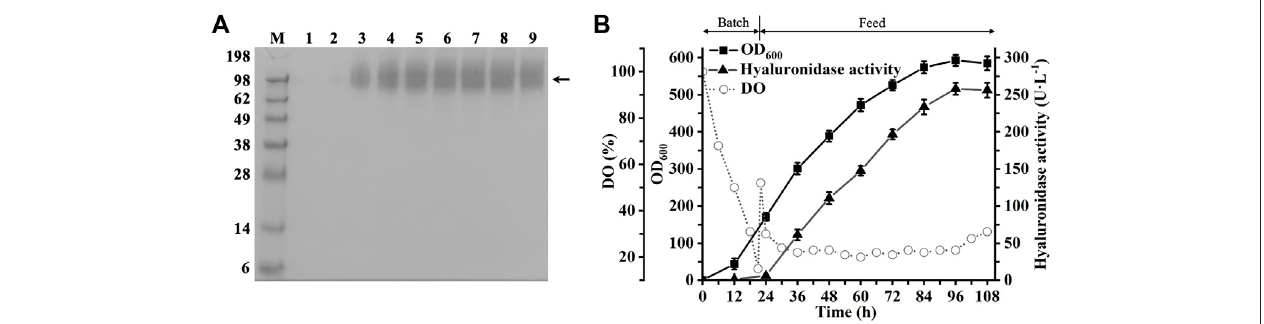
FIGURE 3 | Fed-batch fermentation of recombinant strain P. pastoris GS115-pPIC9K- ap 2 - △ 491C . (A) Western blot analysis of the culture supernatants. M: standard protein marker; 1-9, samples were taken at 12, 24, 36, 48, 60, 72, 84, 96, and 108 h, respectively. The target proteinsare shown bythe black arrow. (B) Time